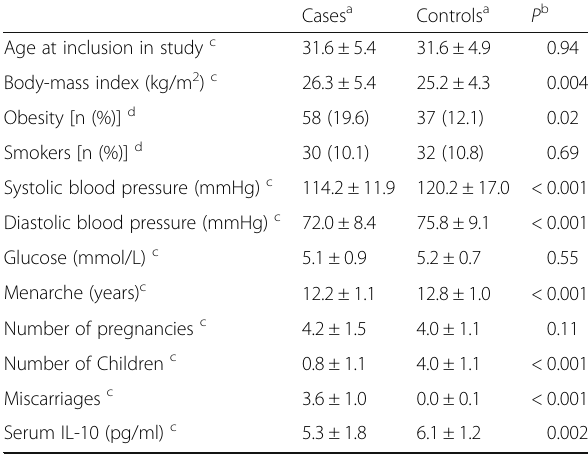
Table 1 Demographics & Clinical Characteristics of Cases